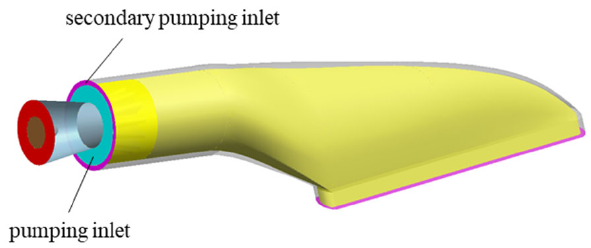
Figure 16. Mixing duct with the shielding sheath.